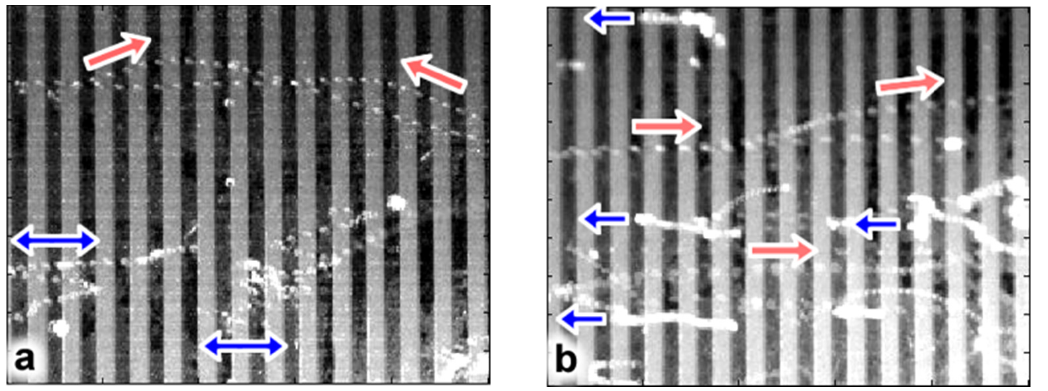
Figure 4. Consecutive overlaid images over a 0.2 s interval (2 ms between images) for both SW and TW fields. ( a ) SW manipulation of glass spheres where both oscillatory rolling (blue arrows) and high velocity repulsion (red arrows) were observed. ( b ) TW manipulation where particles would roll slowly against the field (blue arrows) or be repelled rapidly in the direction of the applied field (red arrows).